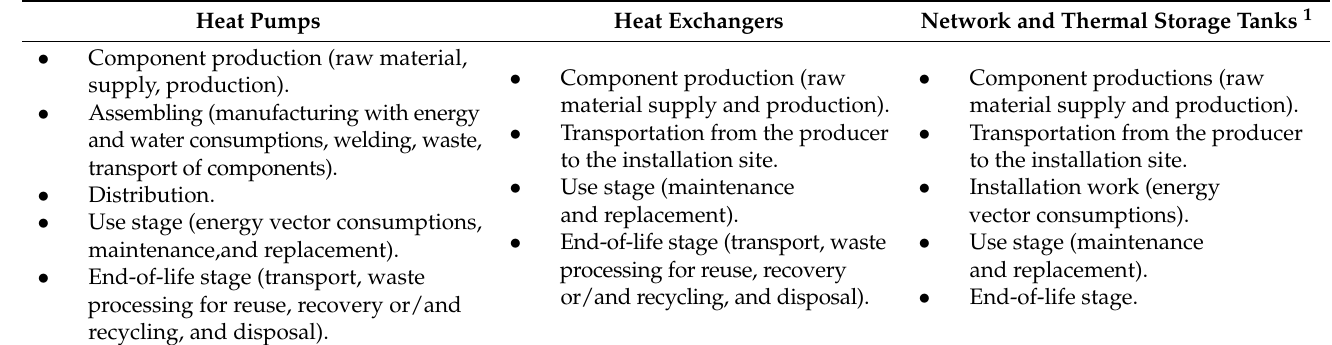
Table 1. Life cycle phases assessed per energy